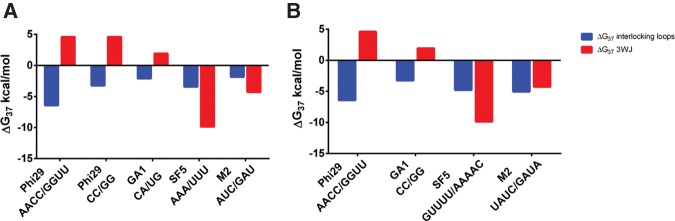
Experimental 3WJ data presented with interlocking loop stabilities calculated using the Nearest Neighbor Database (Turner and Mathews 2010) of sequences reported by (A) Gu and Schroeder (2011) and (B) Hao and Kieft (2014). Interlocking loop sequences are provided for each pRNA. Both the experimental stability data and the calculated stability data were determined for RNA in 1 M NaCl.